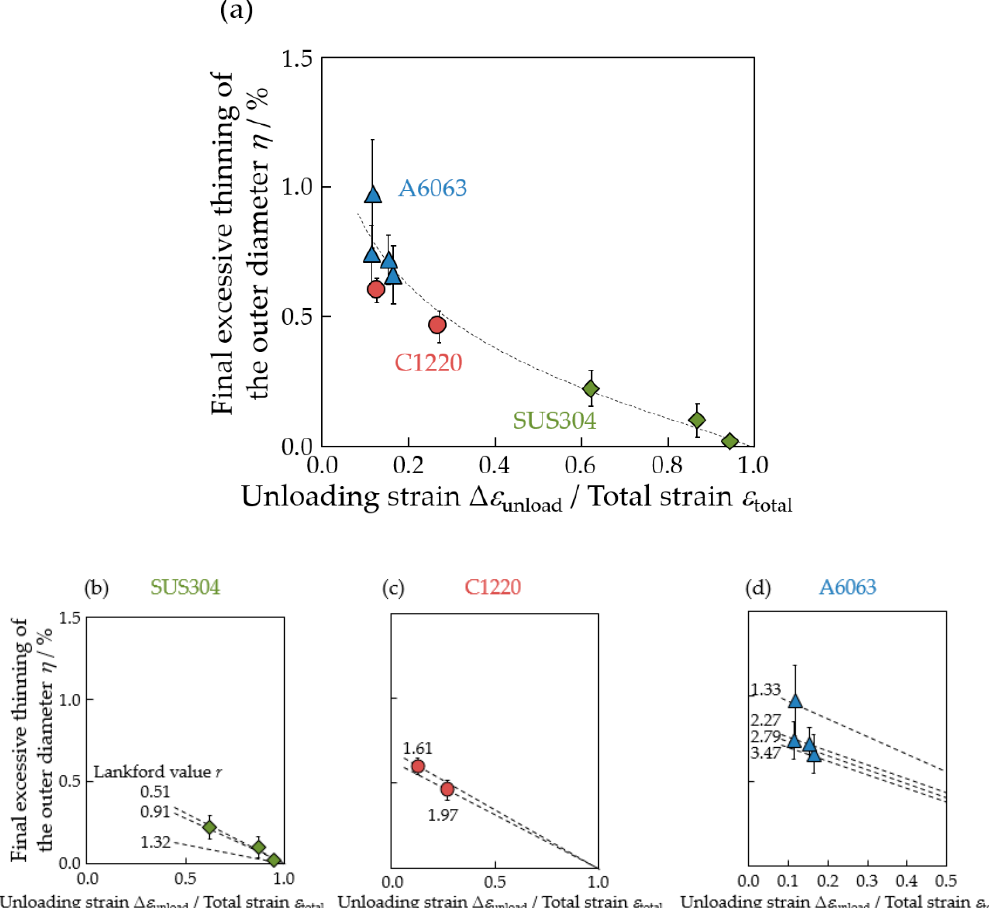
Figure 19. Relationship between the unloading strain ∆ ε unload and the final excessive thinning of the outer diameter η , ( a ) all materials, ( b ) stainless-steel, ( c ) copper, and ( d ) aluminum alloy tubes. The dotted lines indicate the eye guide.